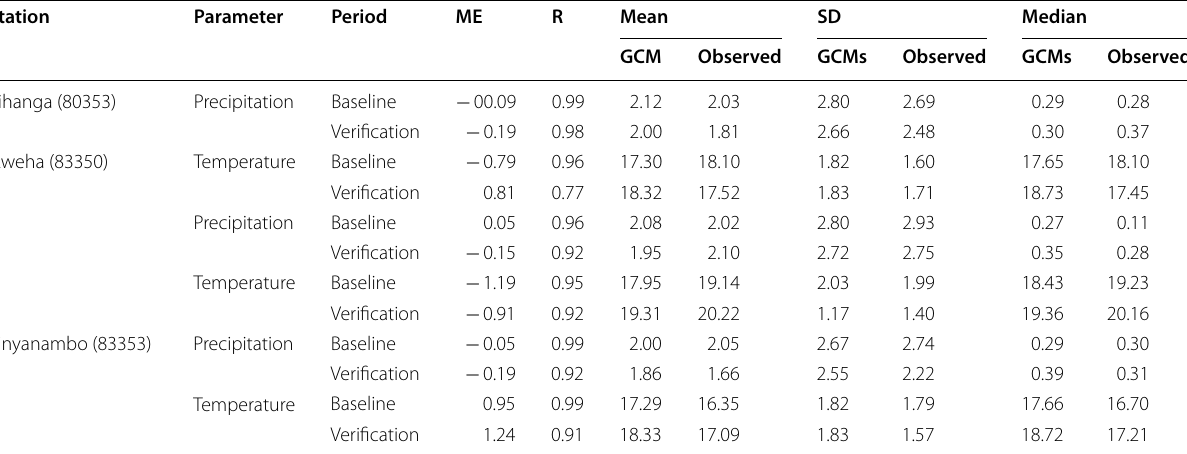
Table 6 Statistical analysis results of the monthly precipitation and temperature for the baseline and verification periods Station